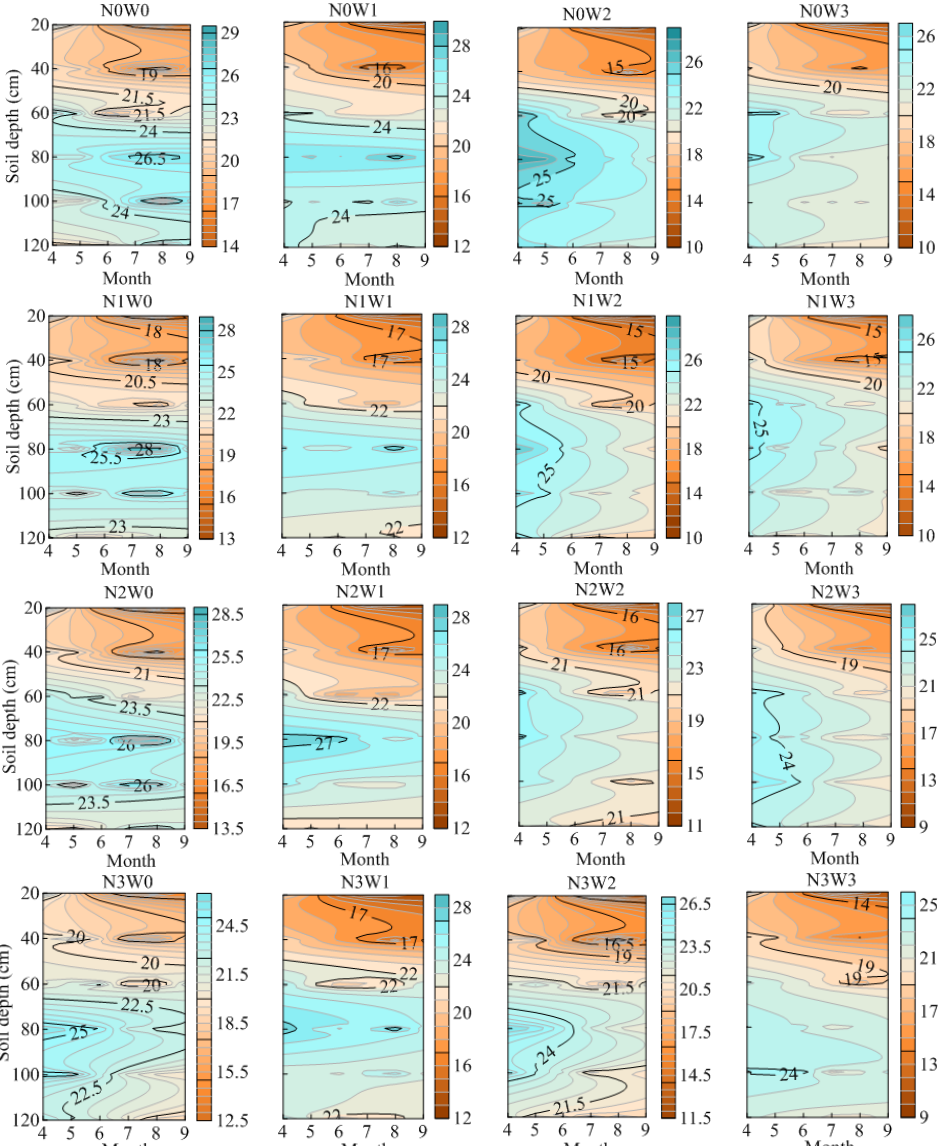
Figure 4. Effects of water-nitrogen regulation on temporal and spatial distribution of soil moisture. The legends on the right of the figure all represent SWC, unit: %. N0, N1, N2 and N3 refers to the nitrogen application level is 0 kg · ha − 1 , 60 kg · ha − 1 , 120 kg · ha − 1 and 180 kg · ha − 1 , respectively. W0, W2 and W3 refers to full irrigation (75 –85% θ f ), slight water deficit (65 –85% θ f ), moderate water deficit (55 –85% θ f ) and severe water deficit (45 –85% θ f ), respectively. The variation of NO 3 − – N content in the 0 – 100 cm soil layer of bromus inermis is shown in Figure 5. At the same irrigation level, the content of NO 3 − – N in different soil layers of N1, N2 and N3 treatments enhanced with increasing cut times. However, increasing cut times decreased the content of the N0 treatment. The content of NO 3 − – N in each treatment decreased with increasing soil depth. The content of NO 3 − – N in the 0 – 40 cm soil layer was most affected by nitrogen application. The content of NO 3 − – N in N1, N2 and N3 treatment